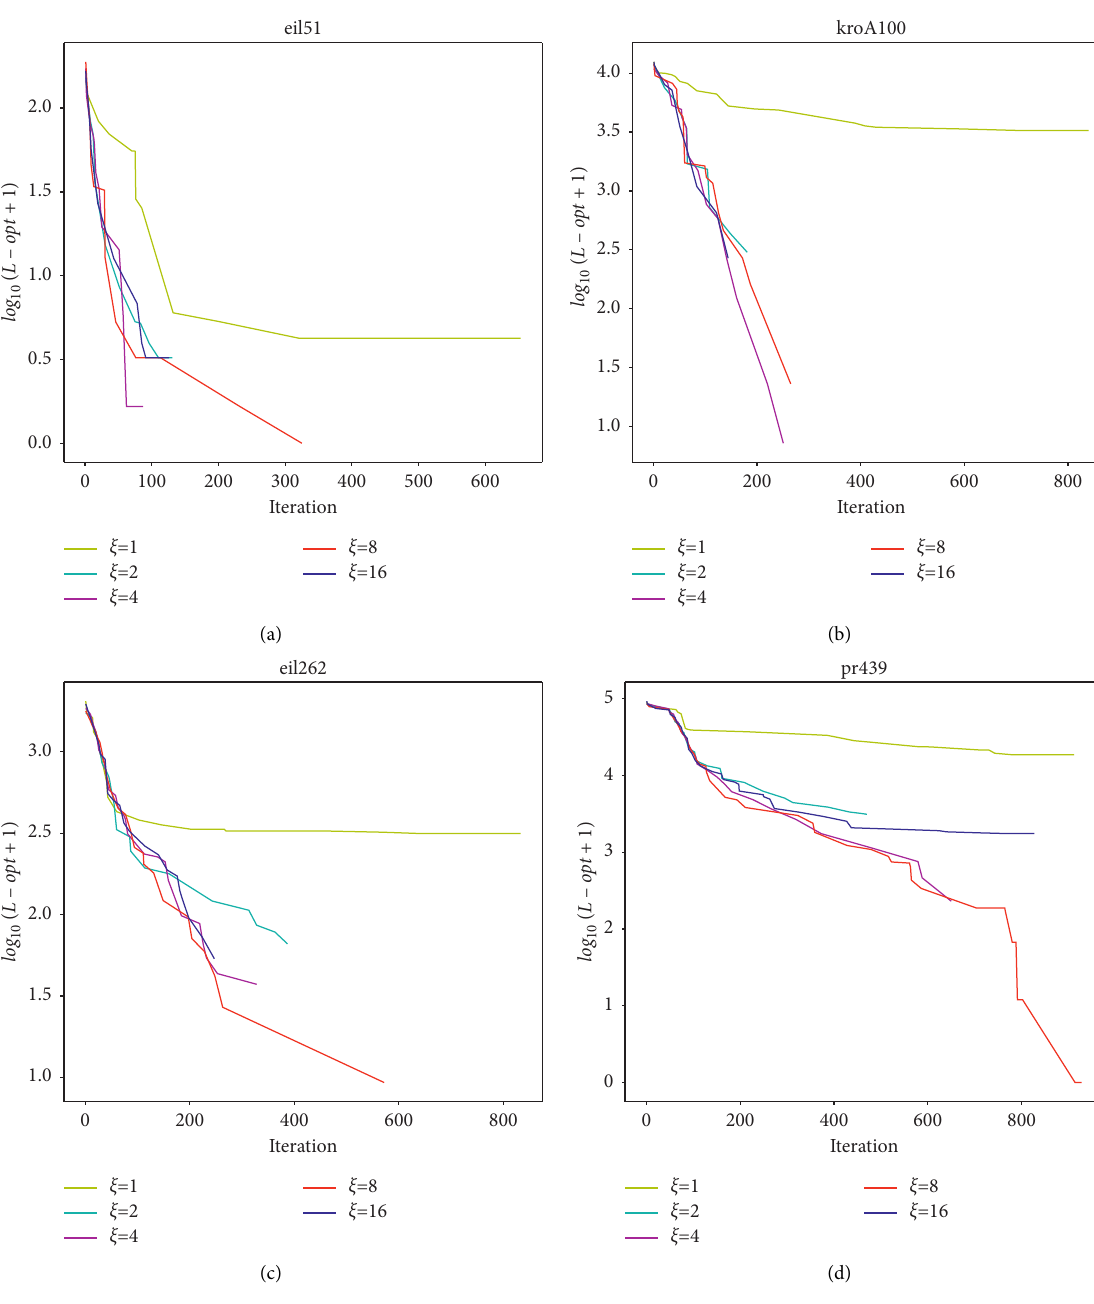
Figure 8: ξ ’s impact. (a) eil51. (b) kroA100. (c) eil262. (d) pr439. Table 3: Ablation